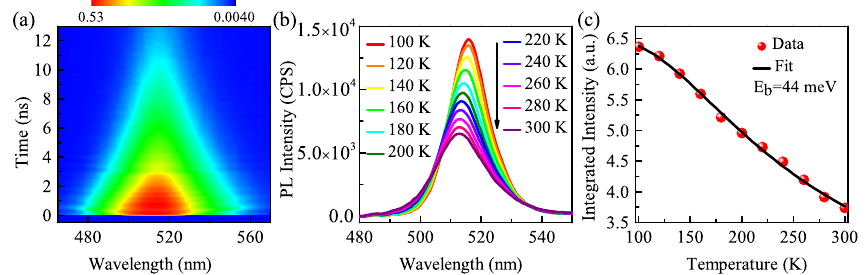
Figure 6. ( a ) Nanosecond time-resolved PL contour. ( b ) Temperature-dependent SS-PL spectra of CsPbBr 3 NCs. ( c ) Integrated PL intensity as a function of temperature. The black solid line represents the fit based on the Formula